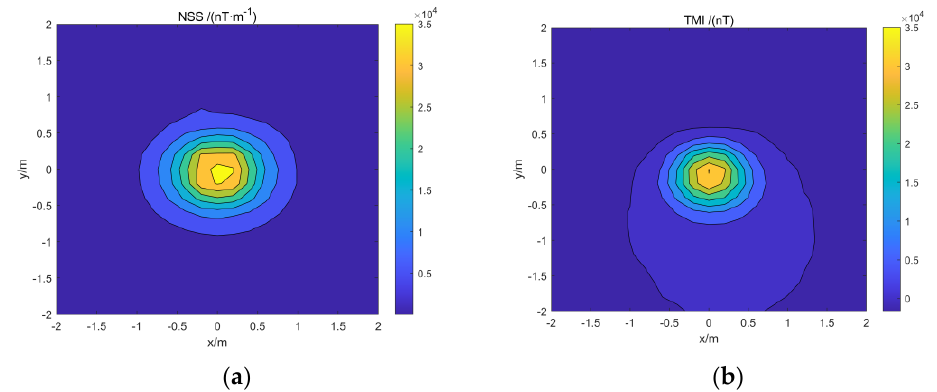
Figure 10. Isolated model simulation data: ( a ) Simulation data for normalized magnetic source strength; ( b ) simulation data of the total magnetic field.